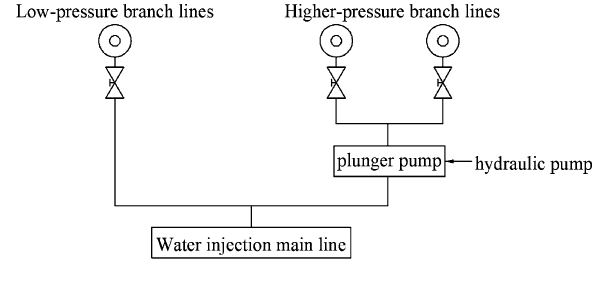
Fig. 3 Functional scheme of the mechanical reversing